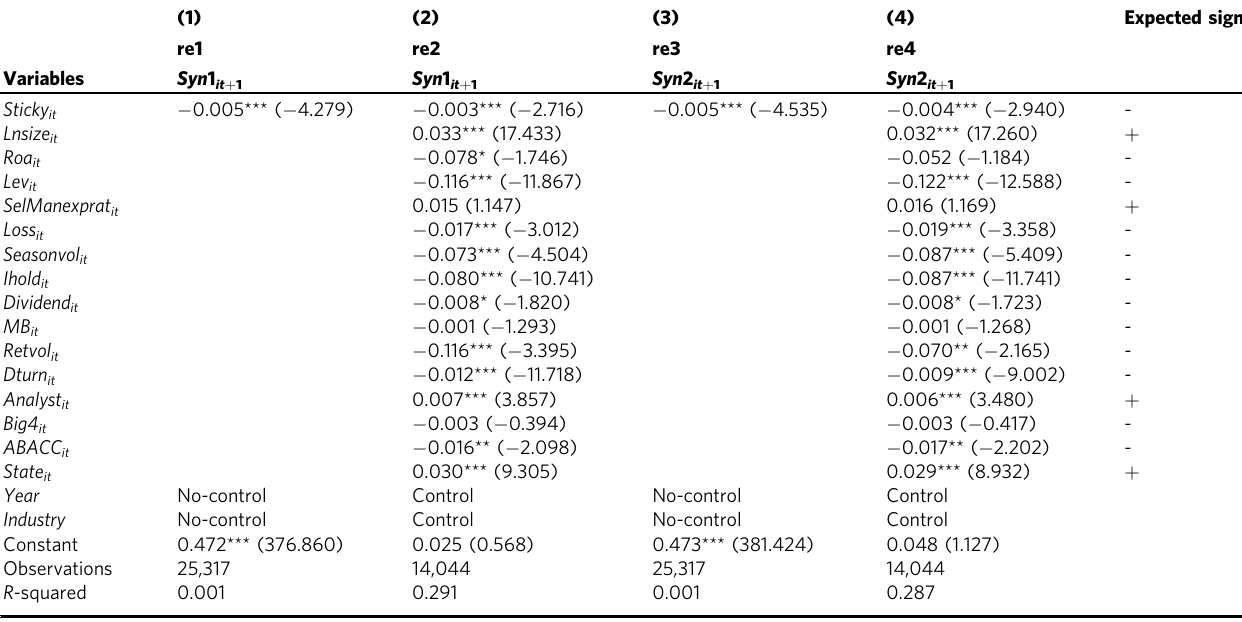
Table 4 Regression table of cost stickiness and stock price